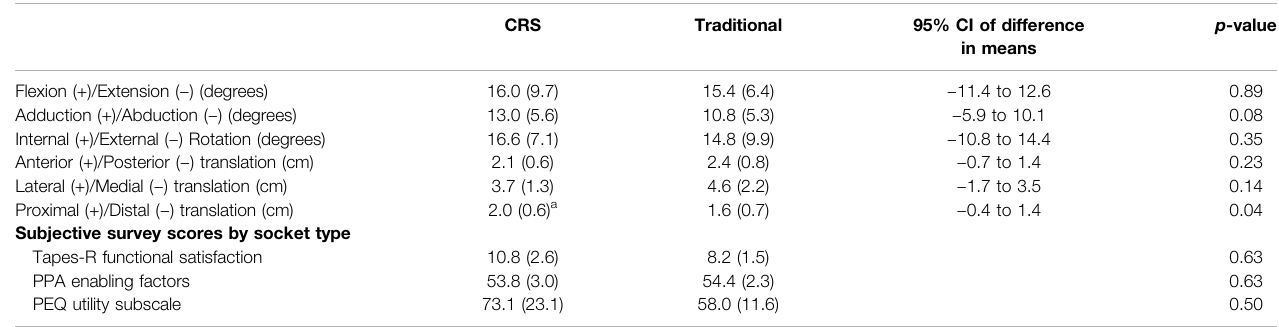
TABLE 2 | Femoral Rotations and Translations by Socket Type and Survey